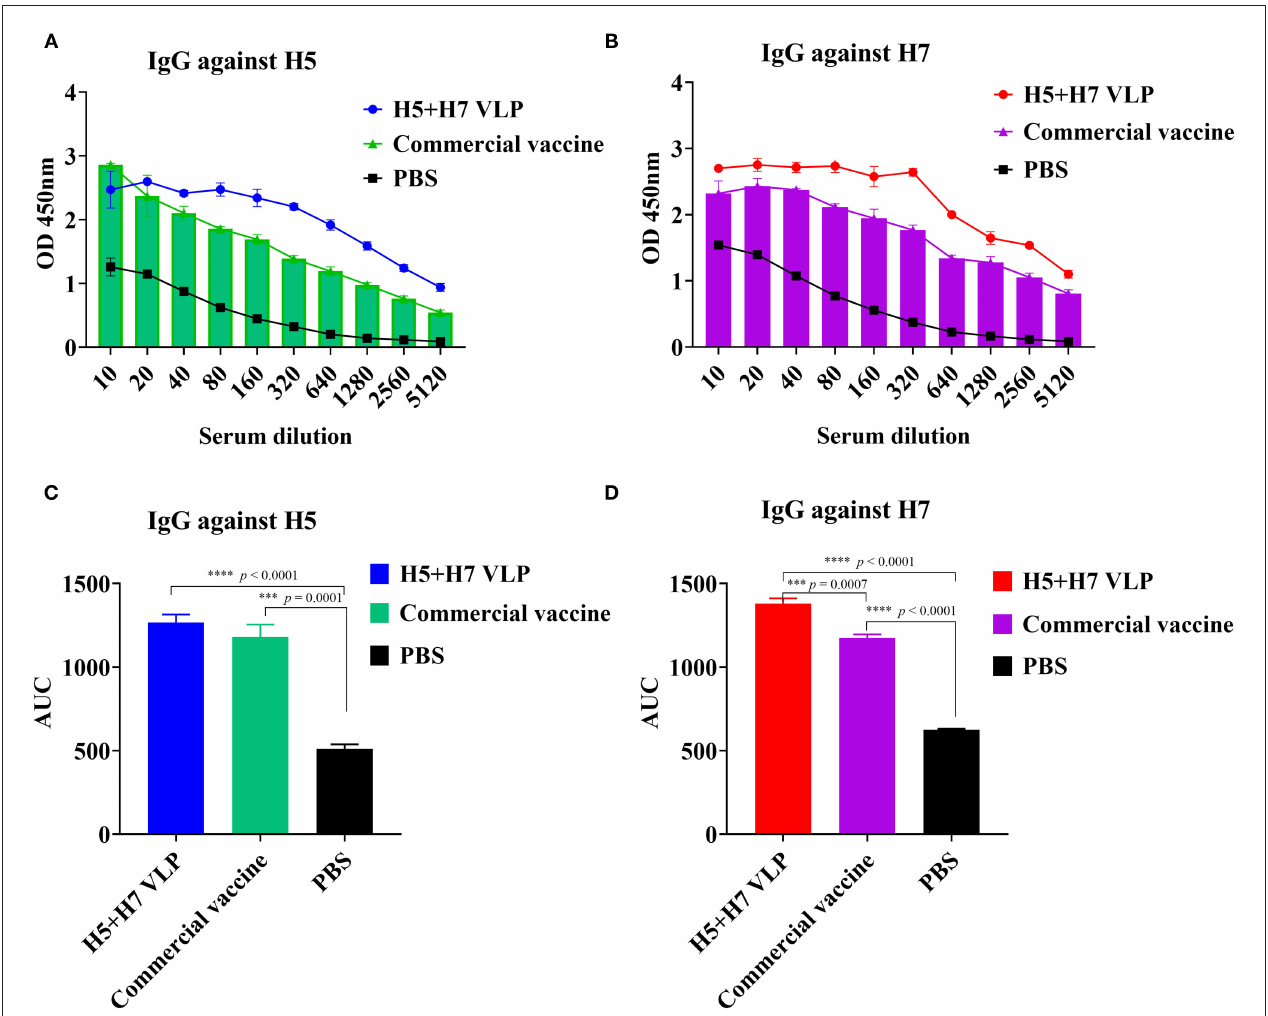
FIGURE 3 | The bivalent H5 + H7 VLP vaccine stimulates strong IgG antibody. Chickens were i.m. immunized with 15 µ g of the bivalent H5 + H7 VLP or 0.3mL of the commercial trivalent (H5: Re-11; H5: Re-12; H7: Re-3) vaccine. The IgG antibody at Week 3 p.v. was determined by ELISA. (A) IgG antibody using purified HA protein of the TT3 virus as coated antigen. (B) IgG antibody using purified HA protein of the A/Chicken/Anhui/AH13/2013 (AH13) virus as coated antigen. (C) Area under the curve (AUC) of the IgG antibody using purified HA protein of the TT3 virus as coated antigen. (D) AUC of the IgG antibody using purified HA protein of the AH13 virus as coated